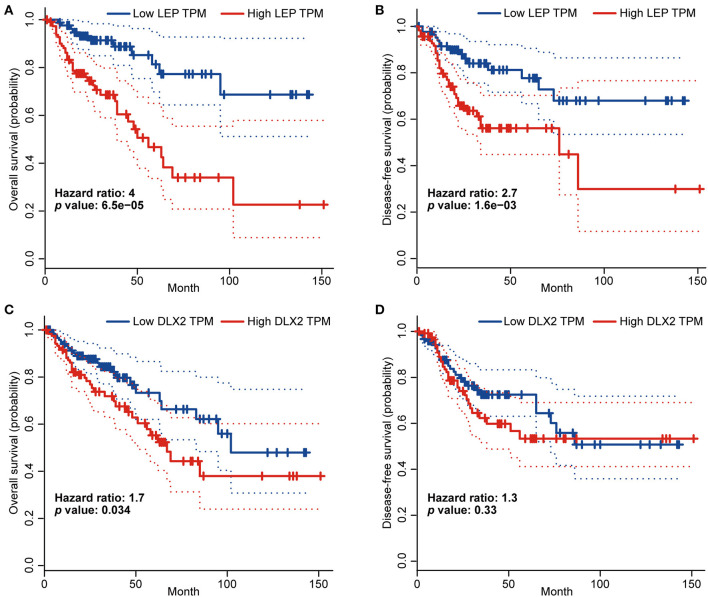
The prognostic values of LEP and DLX2 in COAD patients (GEPIA).The overall survival curve (A) and disease-free survival curve (B) of LEP. The overall survival curve (C) and disease-free survival curve (D) of DLX2.